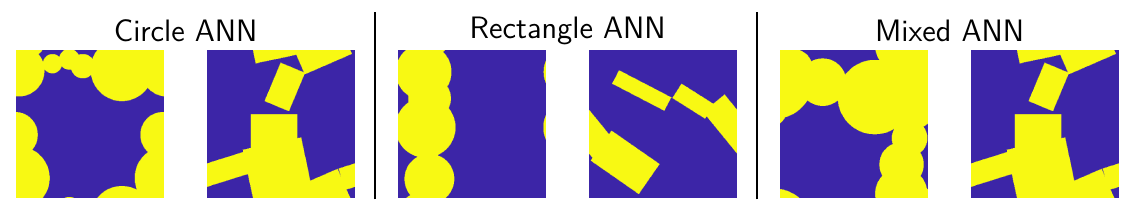
Figure 13. Representative volume element (RVE) with the highest prediction error for each of the ANN models given in Figure